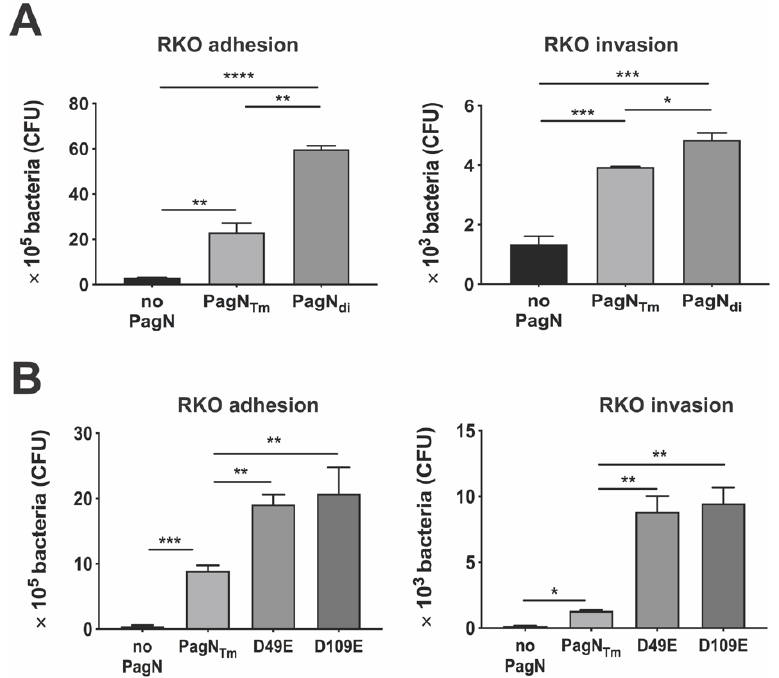
Figure 4. Binding and uptake of E. coli expressing PagN from non- enterica allelic variants. ( A ) Adhesion and invasion of E. coli AAEC189 expressing pagN allele from S. diarizonae PagN (PagN di ) and S. Typhimurium PagN (PagN Tm ) to RKO cells showed the bacteria expressing PagN di binds significantly better than PagN Tm ( p < 0.01) and was slightly more invasive ( p < 0.05). ( B ) A substitution of aspartate to glutamate at site 109 in S. Typhimurium PagN (D109E) increased both binding and invasion of E. coli into RKO cells as compared to the bacteria expressing PagN Tm ( p < 0.01). Data represent one of three separate and reproducible experiments, each with triplicate data expressed as mean ± SEM (* p < 0.05, ** p < 0.01, *** p < 0.001 and **** p < 0.0001). PagN alignments of 48 available strains of S. diarizonae highlighted that they all had an aspartic acid at position 49, like most evaluated subsp. enterica serovars (Typhi being the exception, Figure 1A). In contrast, unlike the subsp. enterica serovars, all PagN di carried a glutamic acid at position 109, suggesting that a D109E substitution at this position would be functionally significant. In support, a D109E substitution in the S. Typhimurium PagN (pDMS 2083) improved not only bacterial binding, but also bacterial uptake by RKO cells (Figure 4B), indicating that glutamic acid in this position